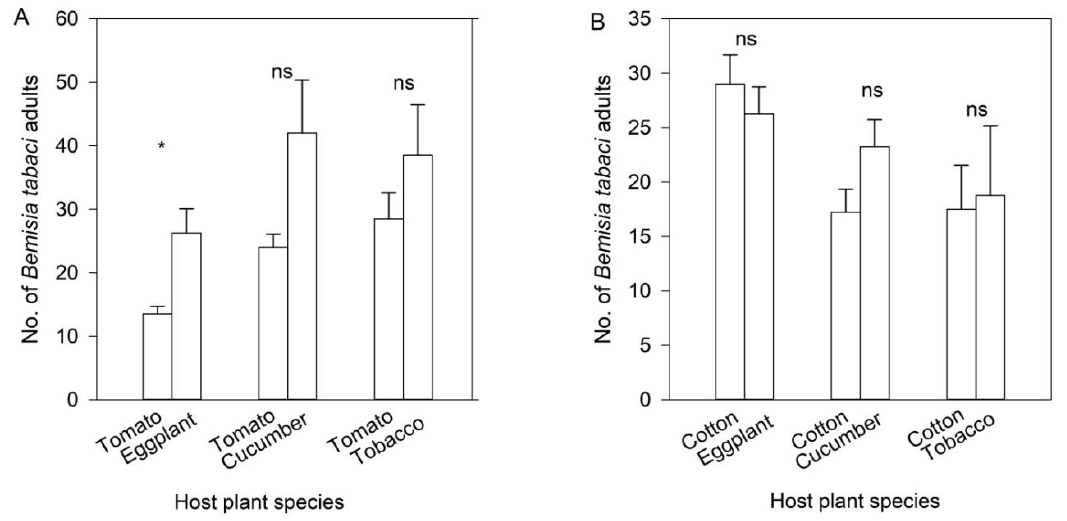
Figure 3. Numbers (mean ± SE) of Bemisia tabaci adults on each plant in the wind tunnel assays. ( A ) Non-preferential tomato versus preferential eggplant, cucumber and tobacco. ( B ) Non-preferential cotton versus preferential eggplant, cucumber and tobacco. The asterisk means significant di ff erence and ns means no di ff erence in each group at p <